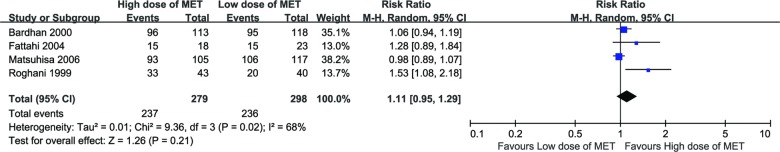
Forest plot of H. pylori eradication rate (per-protocol, PP) with high-dose therapies compared to low-dose therapies.